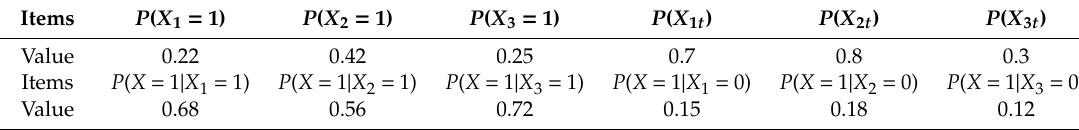
Table 5. Expert score table of node “Seepage of dam foundation” ( × 10 − 4